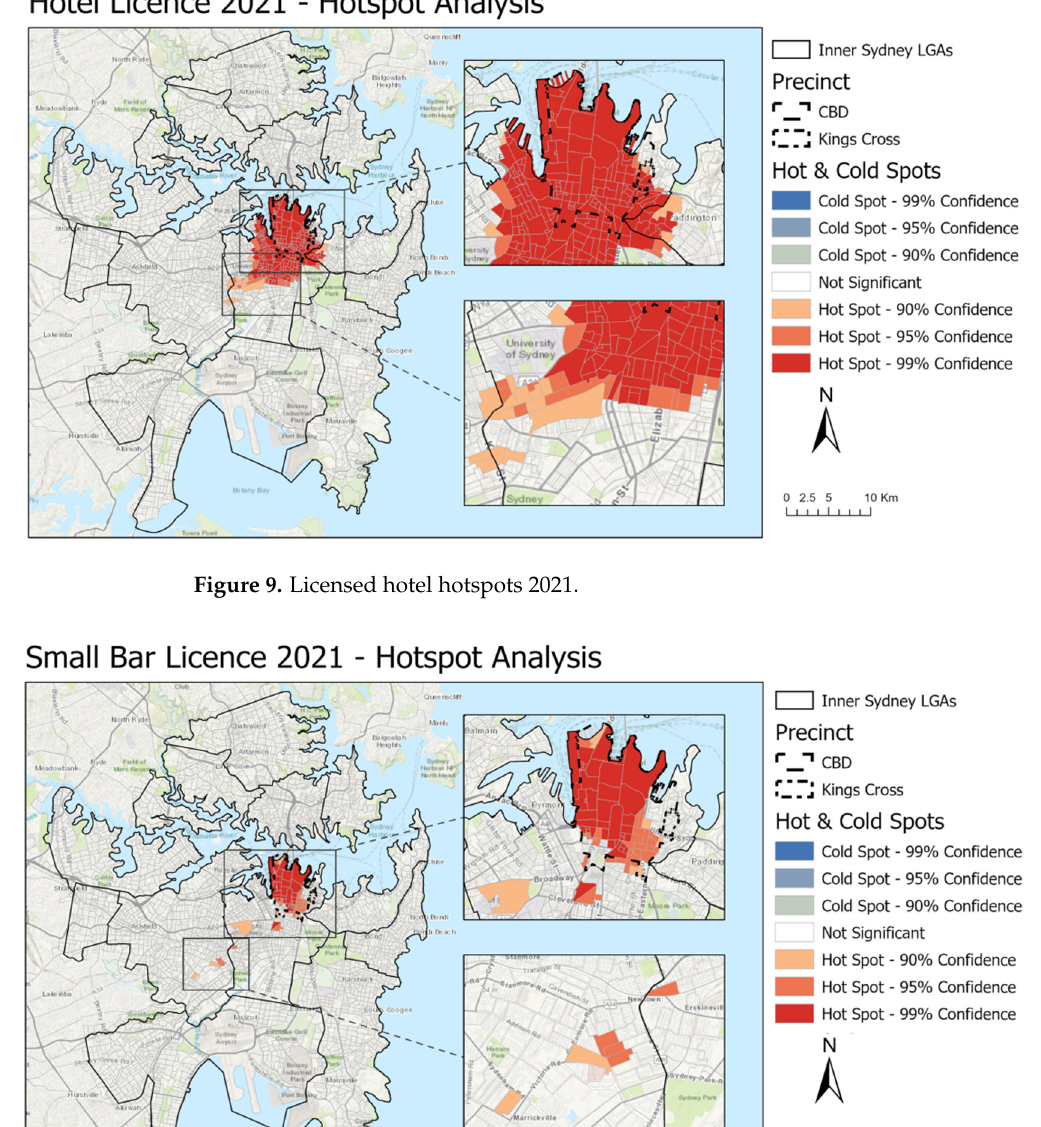
16 of 43 Figure 8. Licensed club hotspots 2021.